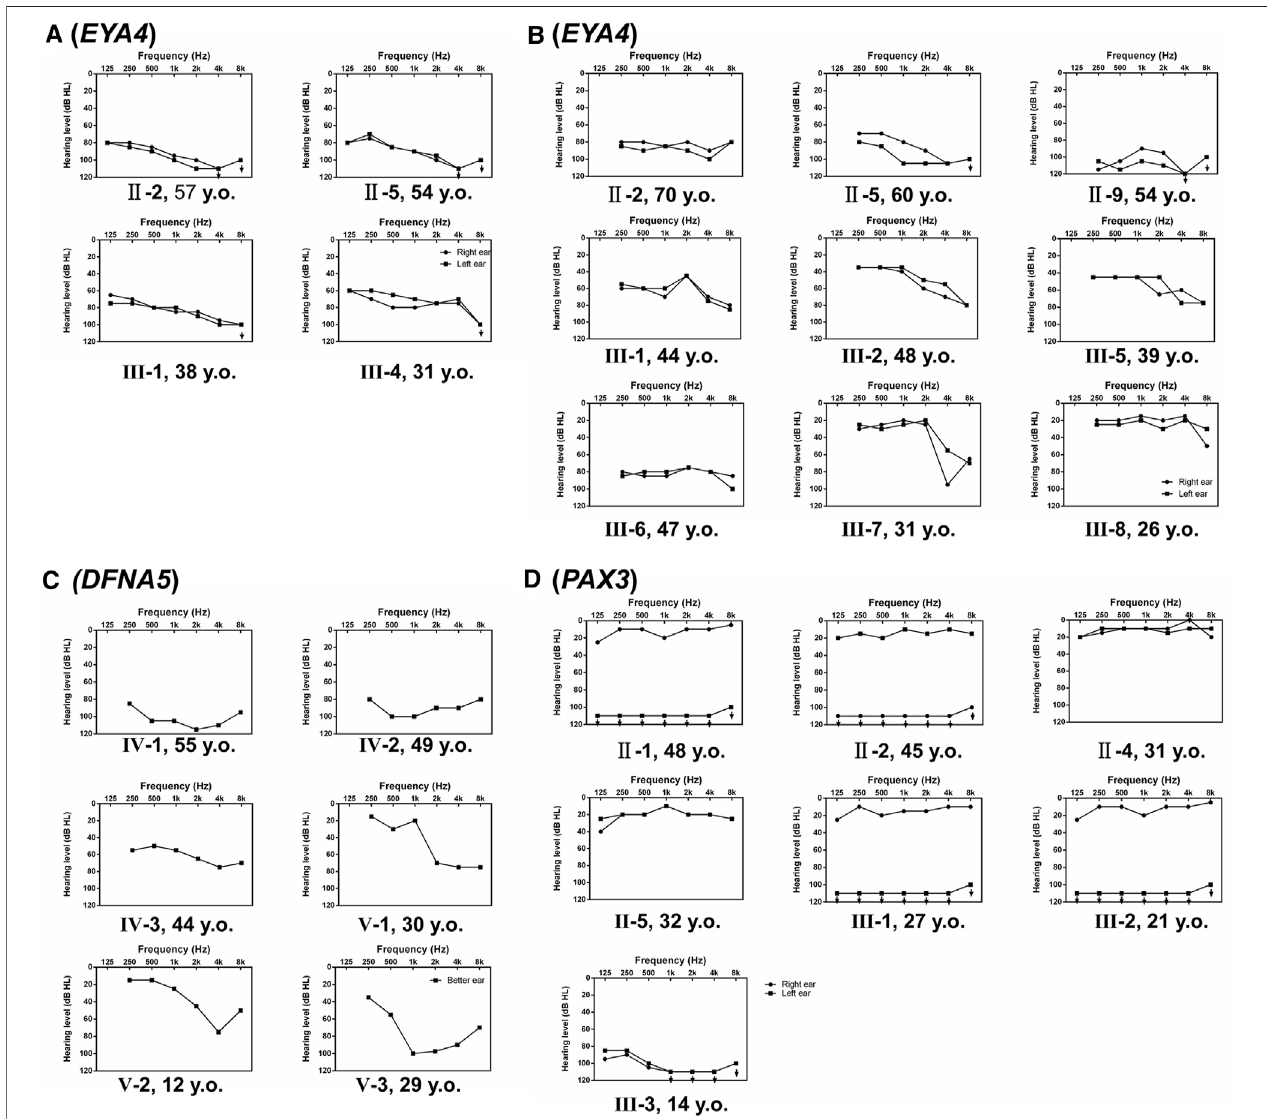
FIGURE 2 | Audiograms of the affected individuals in Families (A – D) , which shows hearing of both ears (A,B,D) or the better ear (C) .